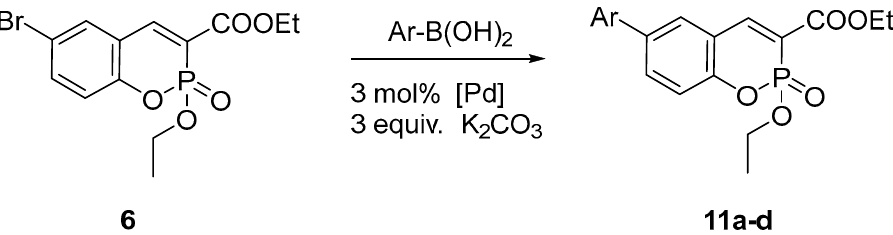
Table 5. Parameters, reagents, and products of palladium-catalyzed arylation of ethyl